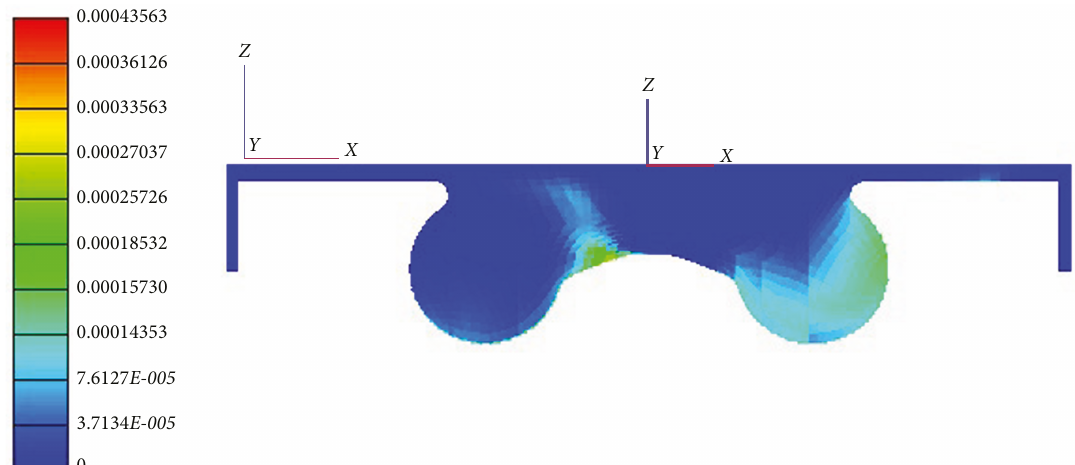
Figure 10: The distribution of soot under 730 ° CA of the original